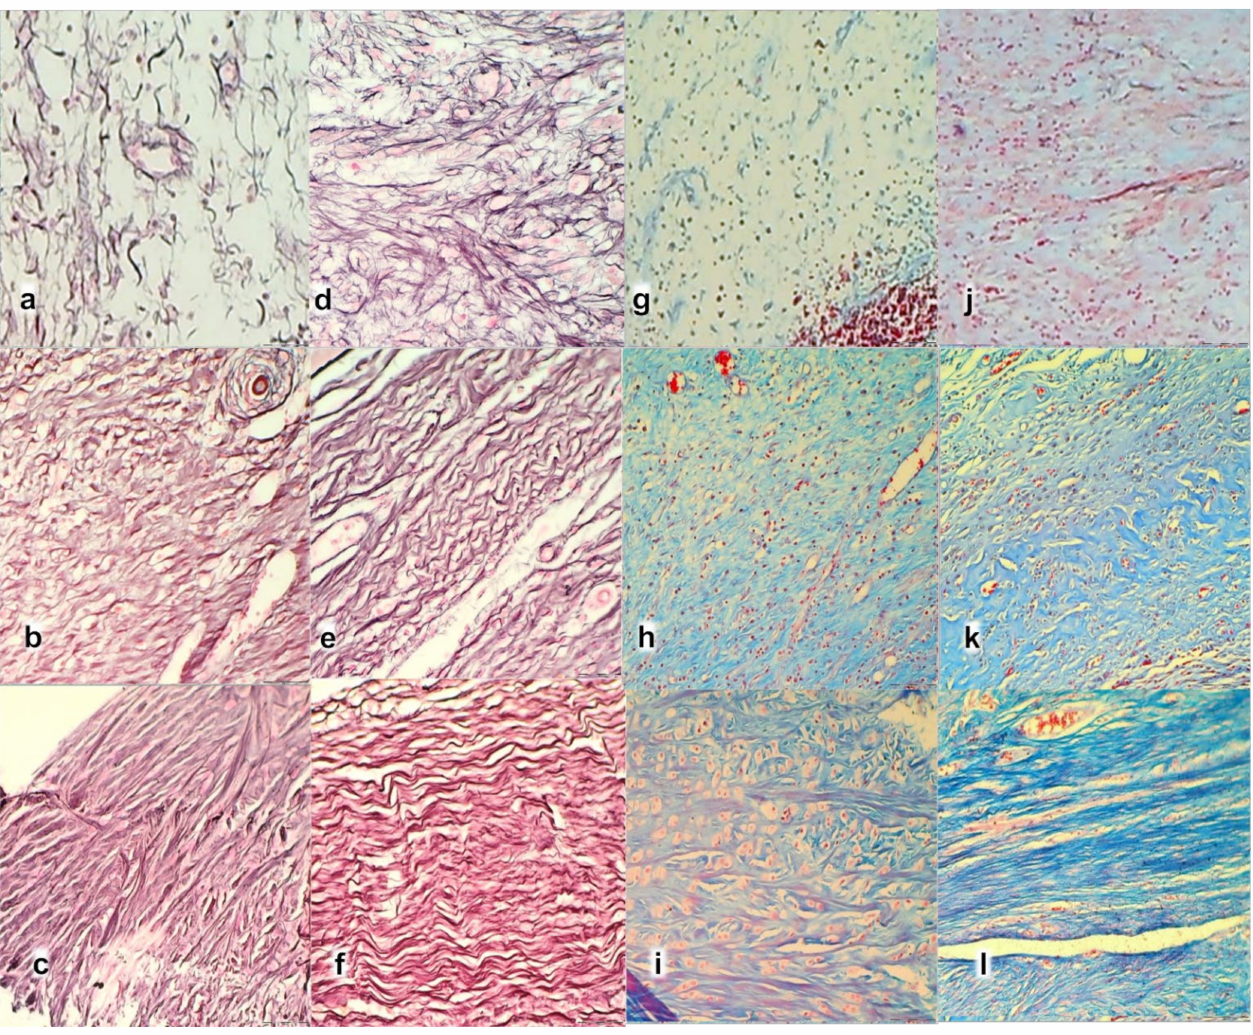
Figure 10. Histochemical staining of myotendinous junction area after myotendinous injury in control ( a – c , g – i ) and BPC 157 treated rats ( d – f , j – l ); at day 7 ( a , d , g , j ), day 14 ( b , e , h , k ), and day 28 ( c , f , i , l ), (Gomori staining ( a – f ); Masson trichrome staining ( g – l ), magnification ×